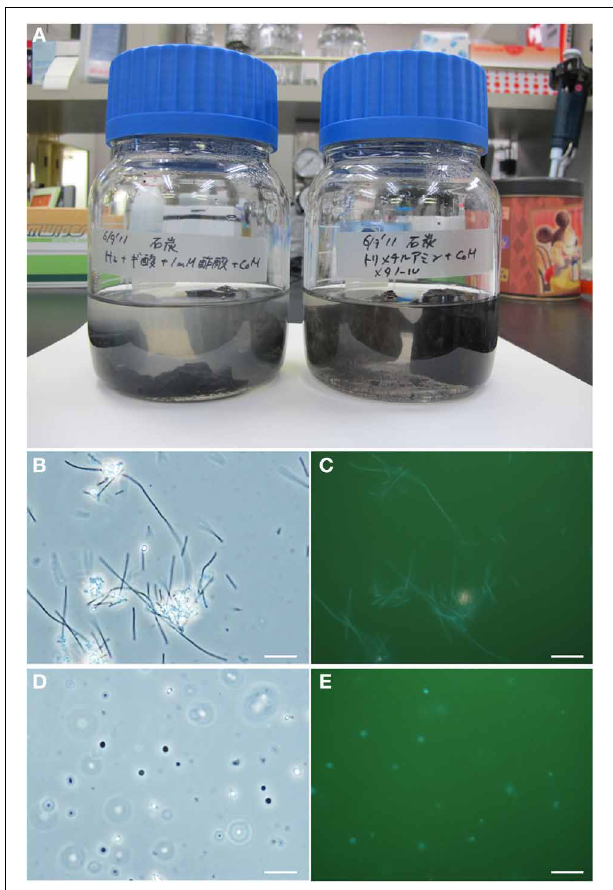
FIGURE 7 | Micrographs of methanogenic enrichment cultures established from the coal sample. (A) Culture bottles. (B–E) Photomicrographs of the enrichment cultures. Phase-contrast micrographs (B,D) and fluorescence micrographs (C,E) of the same fields are shown. (B,C) Rod-shaped methanogen cells grown on H 2 /CO 2 -formate medium; and (D,E) coccoid-shaped methanogen cells grown on methanol-trimethylamine medium. Bars represent 10 μ